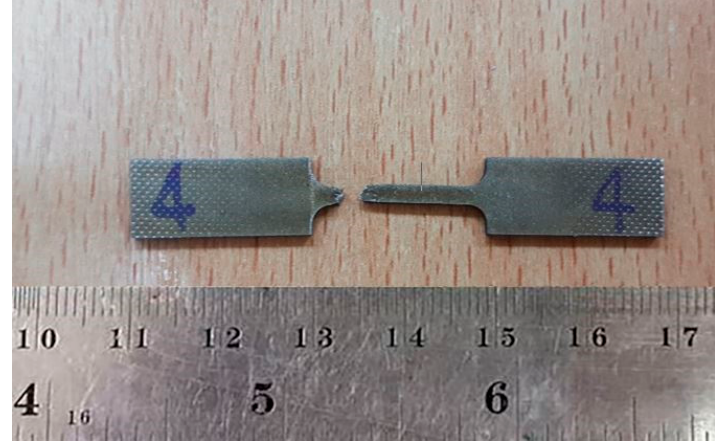
Figure 14. The tensile test specimens (Position 4).